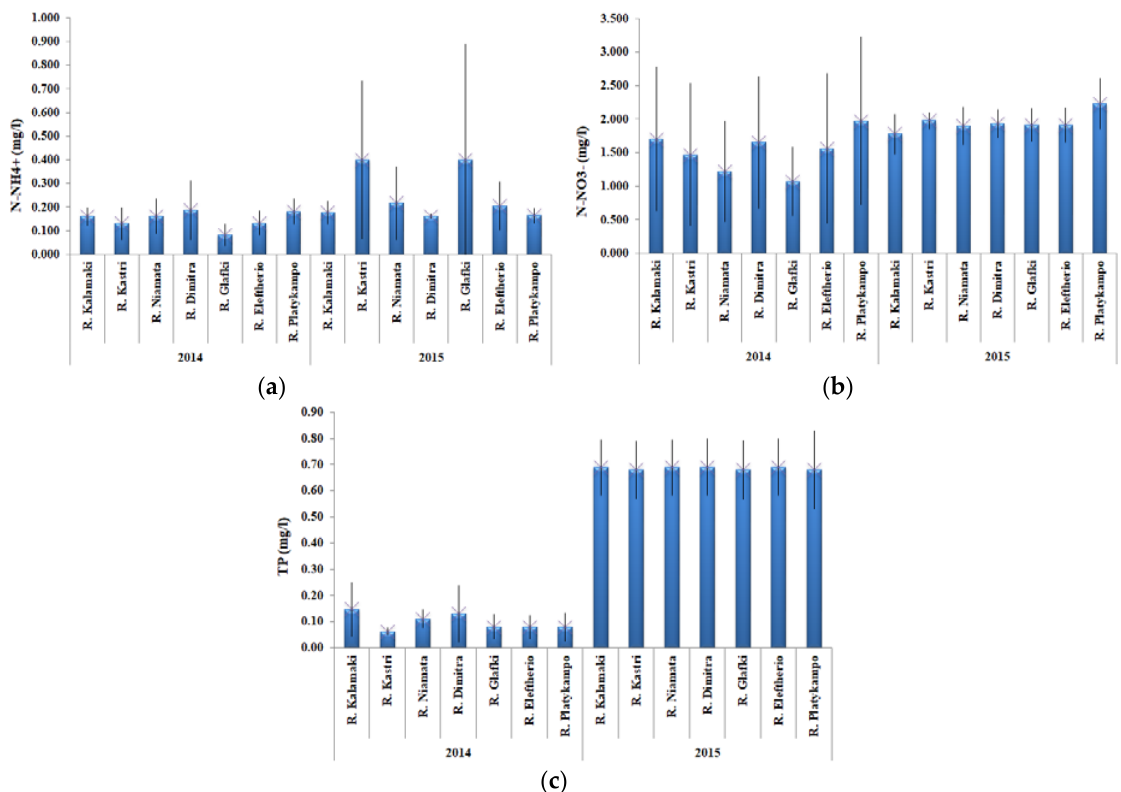
Figure 3. Bars represent mean values of nitrite, ammonium and total phosphorus concentrations at each reservoir during the sampling period. ( a ) nitrite concentrations; ( b ) ammonium concentrations; ( c ) total phosphorus concentrations. Table 2. Pearson correlations between the nutrient variables measured during the current study in